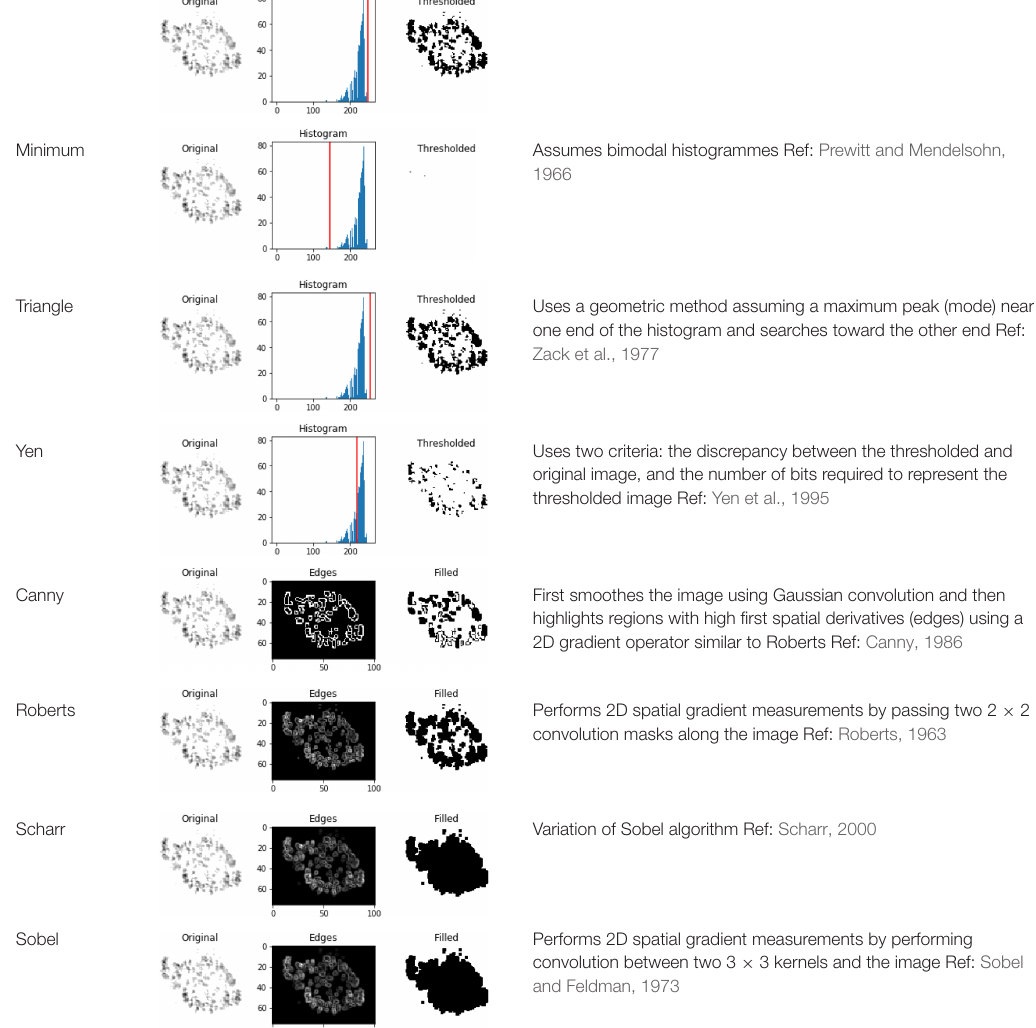
Variation of Sobel algorithm Ref: Scharr, 2000